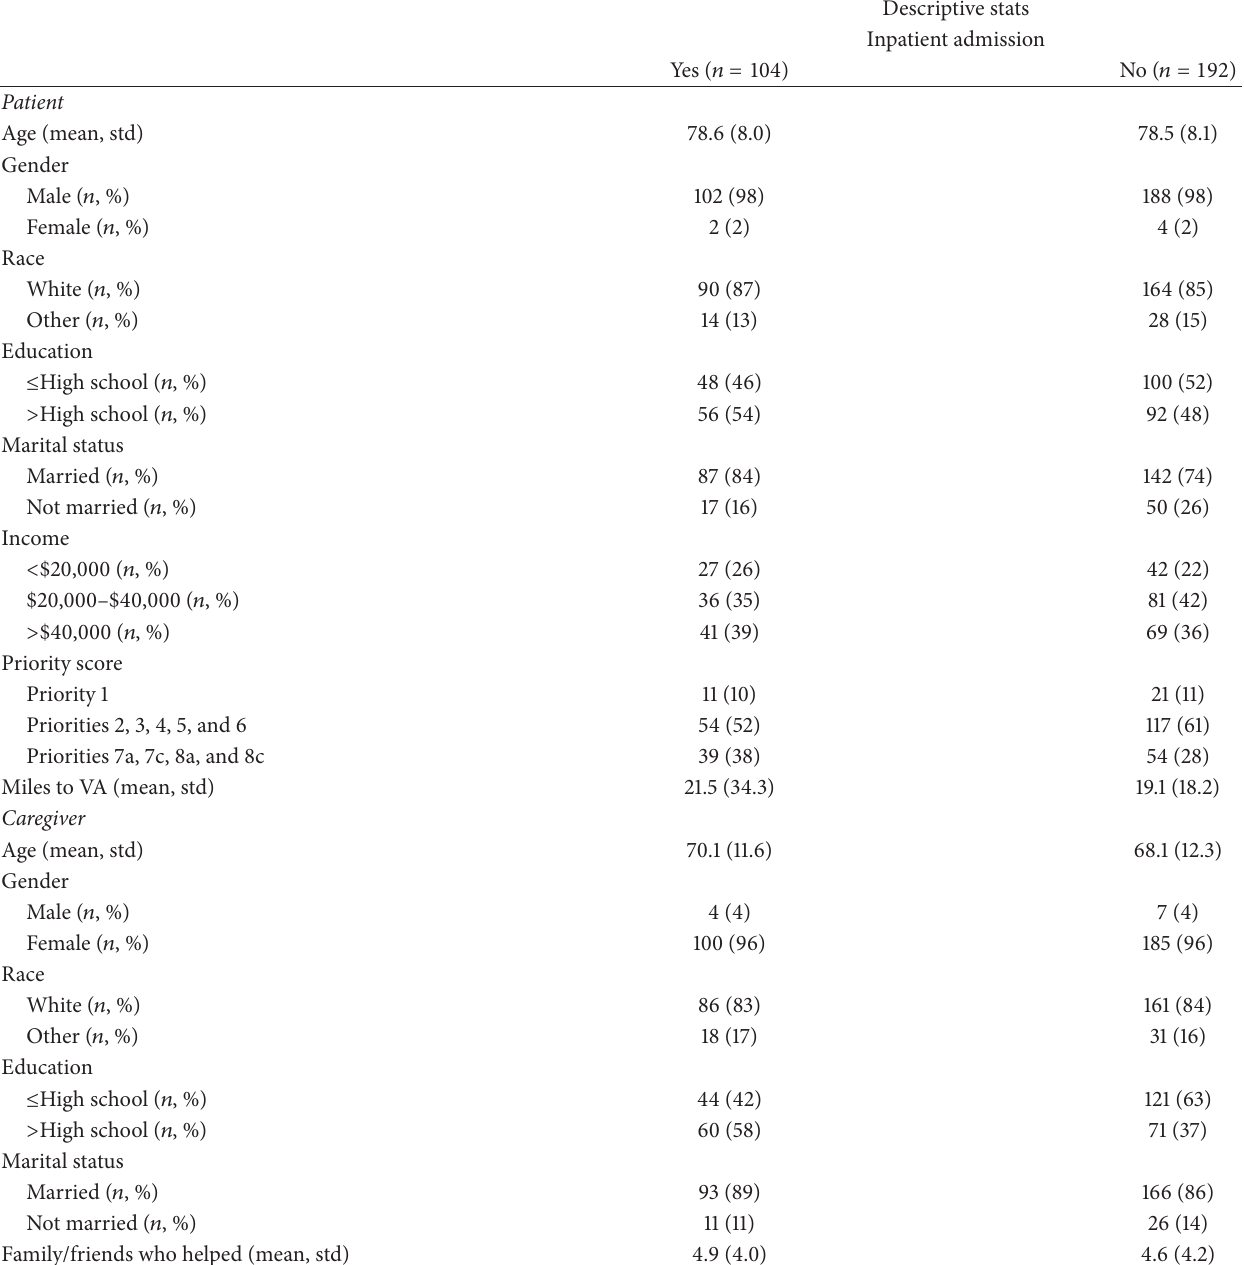
Table 1: Descriptive statistics of demographic variables for persons with dementia and their